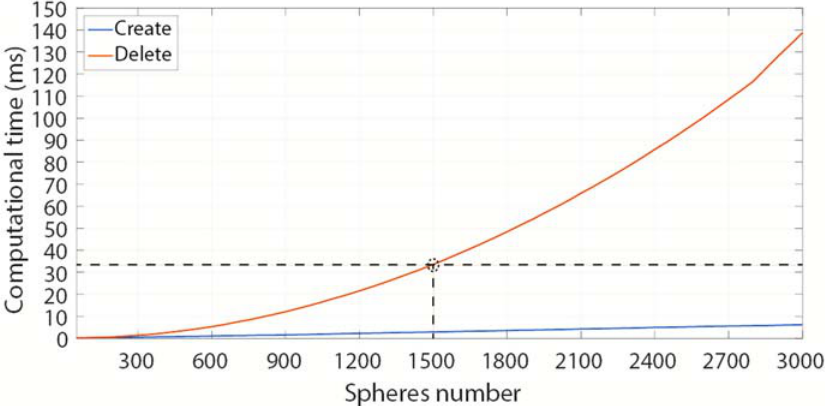
Figure 6. Computational time required to create and delete spheres with the CPS. The computational time constraint (i.e., 33.3 ms) of the application is also depicted with a dashed line.